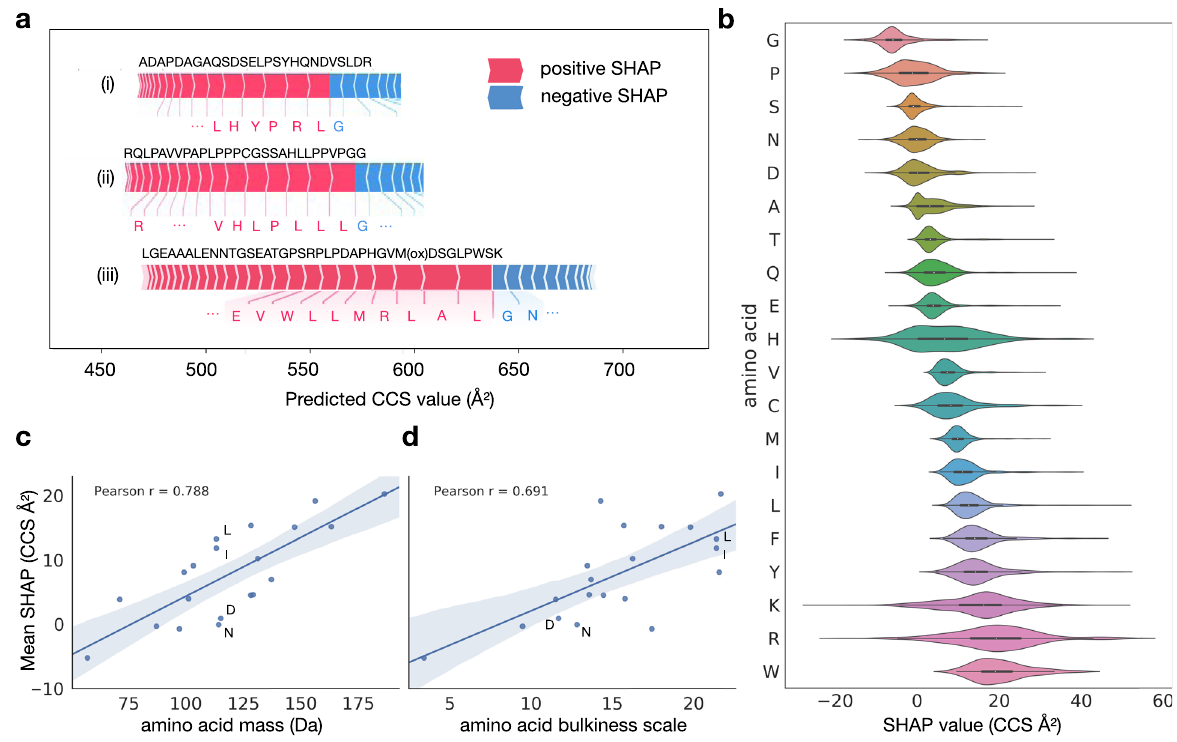
Fig. 5 Explainable arti fi cial intelligence reveals context-dependent amino acid contributions. a Example peptide sequences with SHAP value attributions of the most in fl uential amino acids in the linear sequence. b Amino acid-speci fi c SHAP value distributions over the test dataset. Data are presented as violin plots showing kernel density estimates and boxplots with the following elements: median (center), 25 th and 75 th percentiles (lower and upper box limits), the 1.5× interquartile range (whiskers); n = 100,000 sequences. c Correlation between amino acid mass and mean SHAP value. d Correlation between amino acid bulkiness 59 and mean SHAP